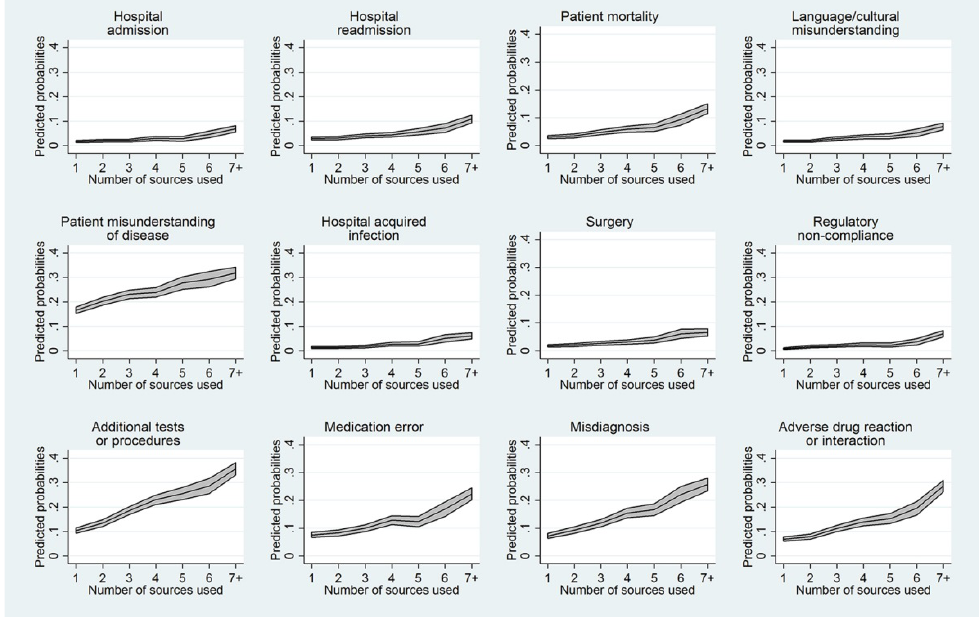
Figure 3 Predicted probabilities for adverse events avoided (with 95% confidence intervals), depending on the number of information resources